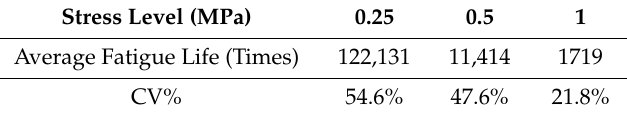
Table 6. The test result of direct tensile.